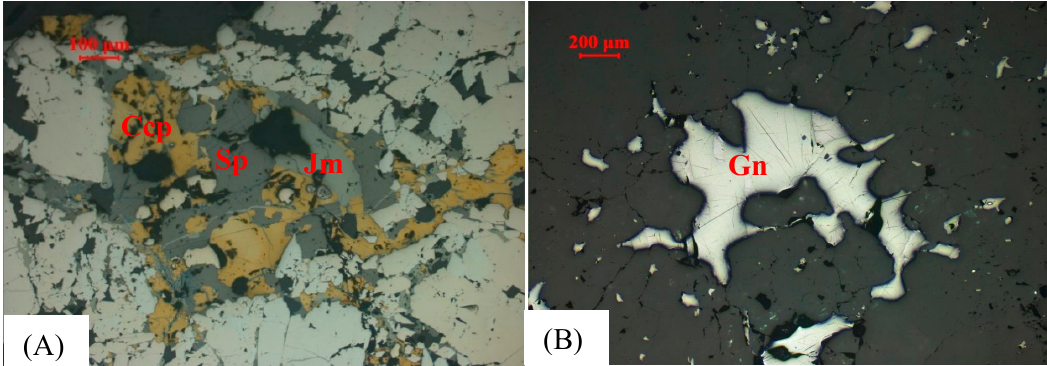
Figure 8. Images of other sulphides in reflected light: ( A ) aggregate of sphalerite, jamesonite, and chalcopyrite; ( B ) image of galena (Sp—sphalerite; Ccp—chalcopyrite; Jm—jamesonite; Gn—galena).